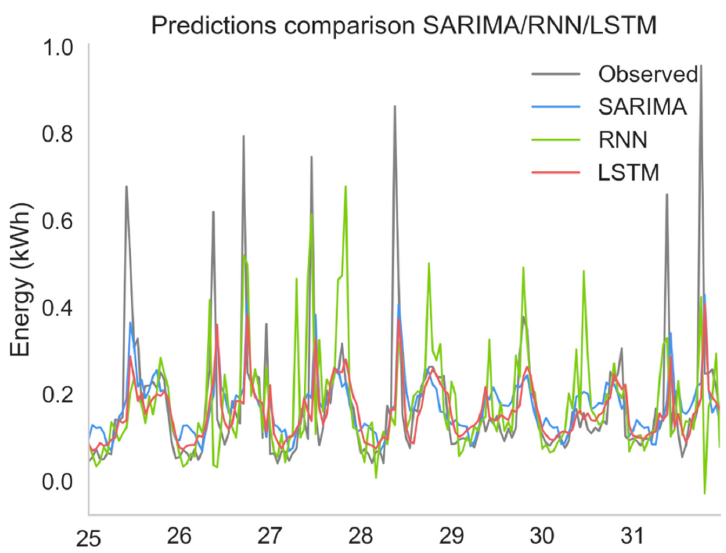
Figure 13. Prediction comparison of 3 different forecasting algorithms—SARIMA, RNN and LSTM.